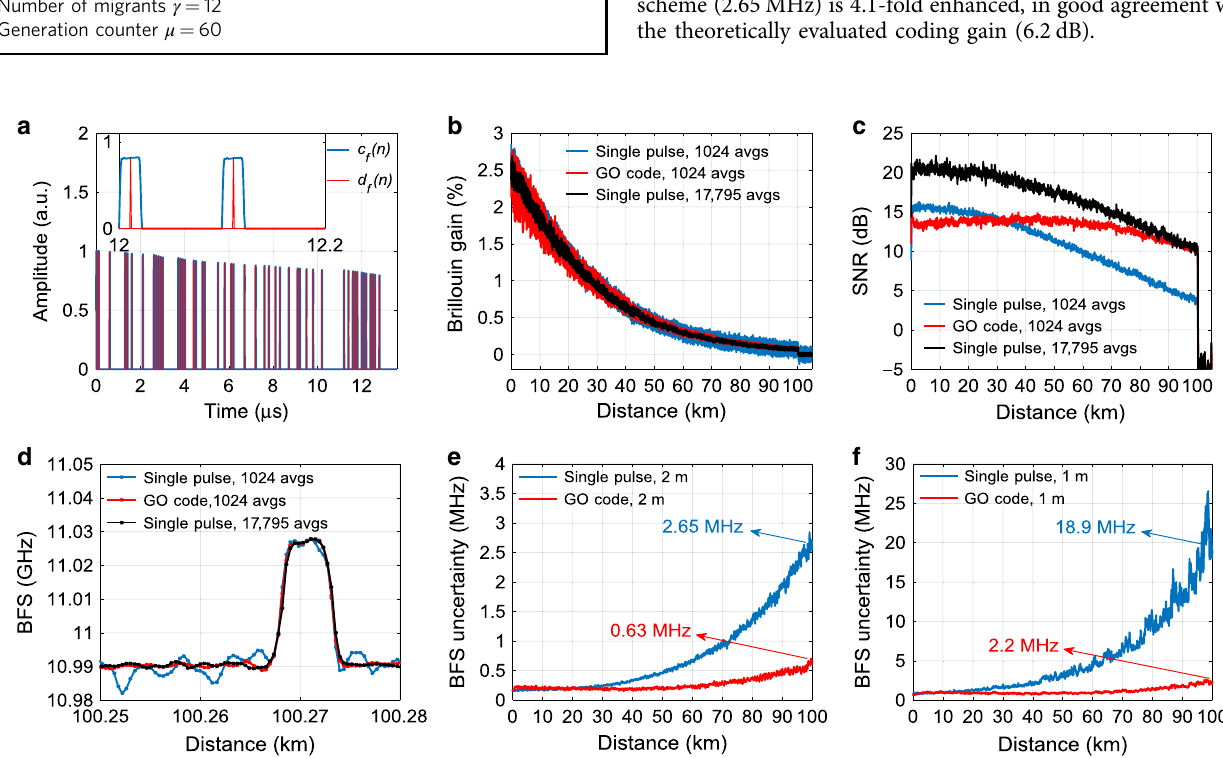
Fig. 3 Experimental results of GO-coded and single-pulse BOTDA. a A 136-bit normalised coding sequence c f ( n ) measured at the fi bre input (blue) and the retrieved d f ( n ) (red). Inset: Zoom-in of normalised c f ( n ) and d f ( n ) over a time span from 12 to 12.2 μ s. b Temporal BOTDA gain traces at fi bre Brillouin resonance. c SNR pro fi les over the entire sensing fi bre. d Measured BFS pro fi les around a 5-m-long hotspot located near the fi bre far-end. e , f BFS uncertainty pro fi les along with the sensing fi bre for 2 and 1 m SRs,